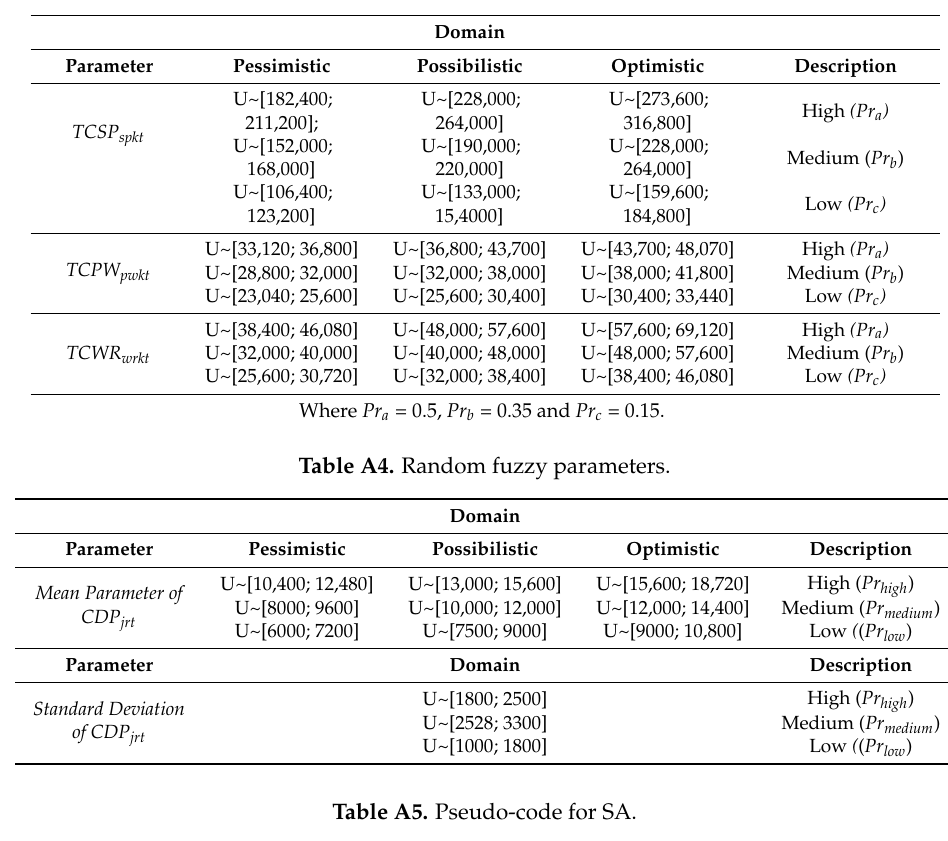
Table A3. Fuzzy random parameters.